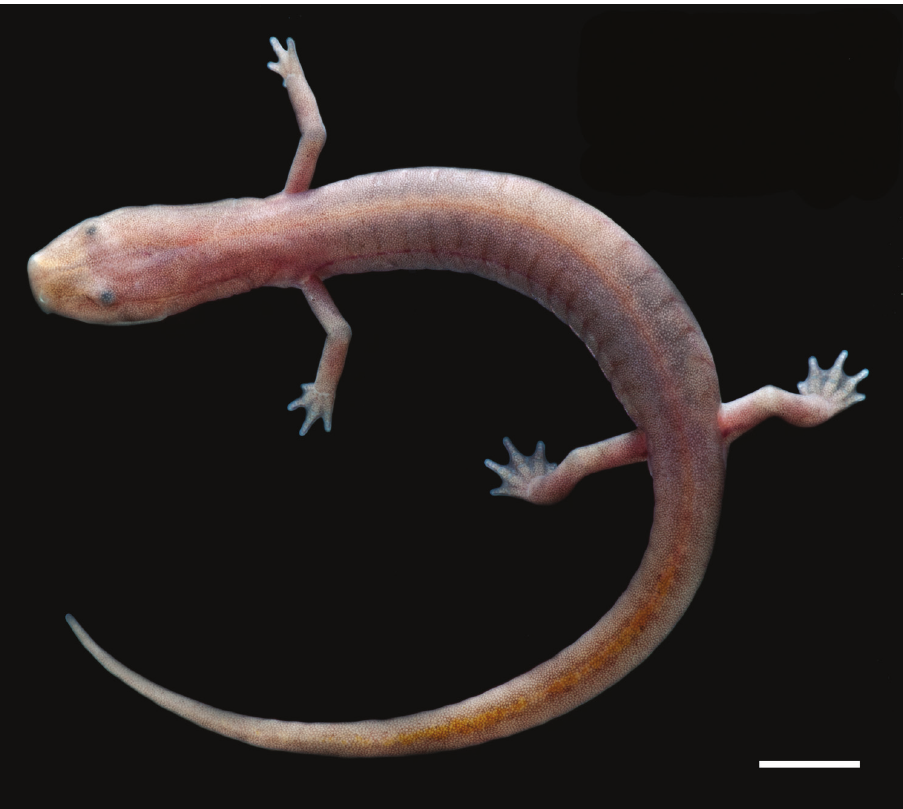
Figure 1 . Eurycea spelaea showing troglobitic characters, lack of pigmentation and microphthalmy. Scale bar: 0.5